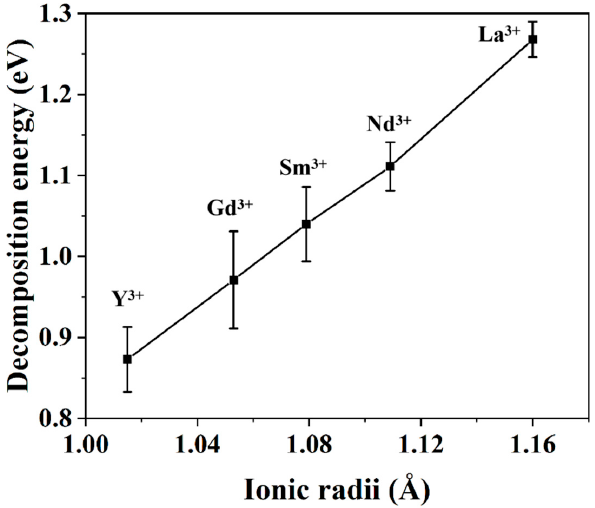
Figure 10. The decomposition energy of rare earth-stabilized ZrO 2 calculated using lattice dynam- ics simulation.